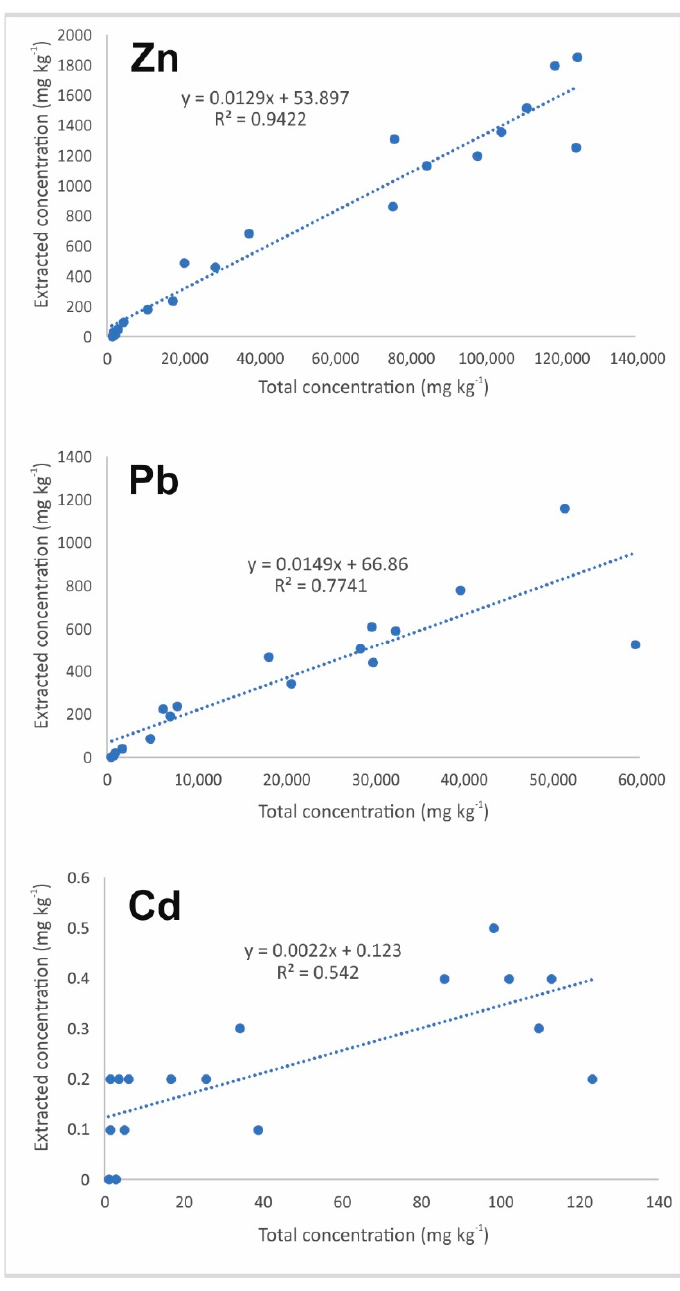
Figure 7. Correlations between the total and extracted concentrations of Pb, Zn and Cd in the soil.